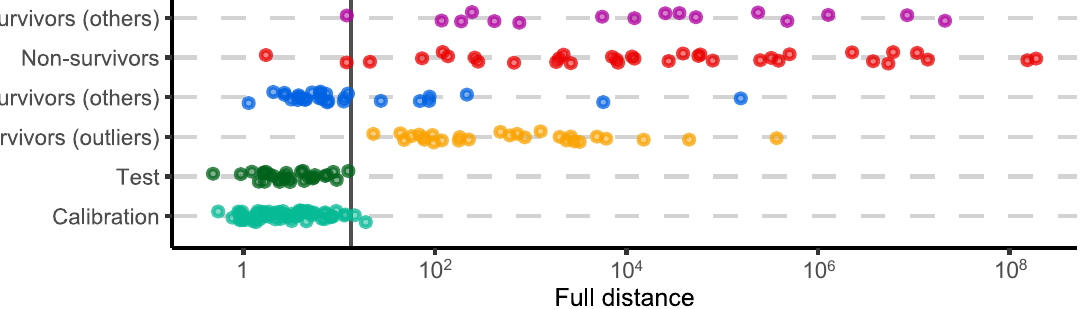
Figure 3. One-dimensional visualization of the results obtained with SIMCA. The model was built without p -HPhLA. The vertical line is the decision rule ( α = 0.01). Points are scattered along the y-axis to improve perception in the case of overlapping.